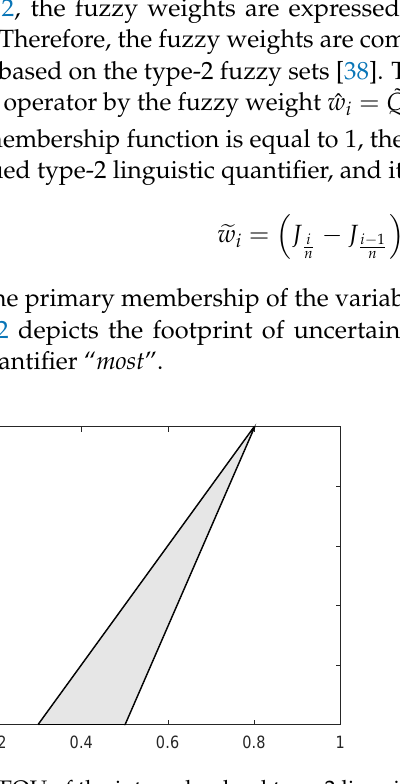
Figure 2. The FOU of the interval-valued type-2 linguistic quantifier “ most